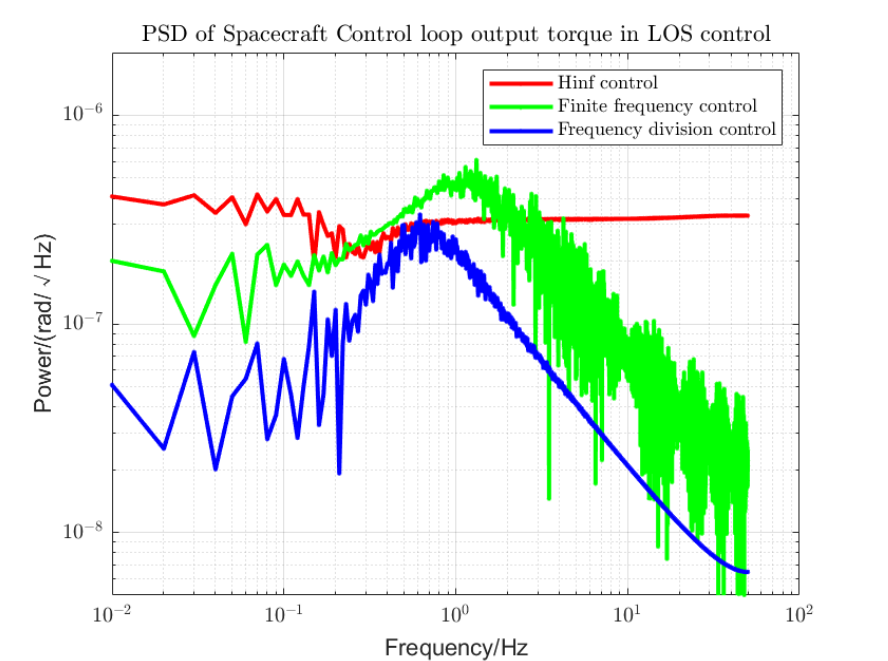
Figure 6. PSD of S/C Control loop output torque. The control performances of the loop-shaping H-infinity control, finite frequency control, and frequency division control are compared.